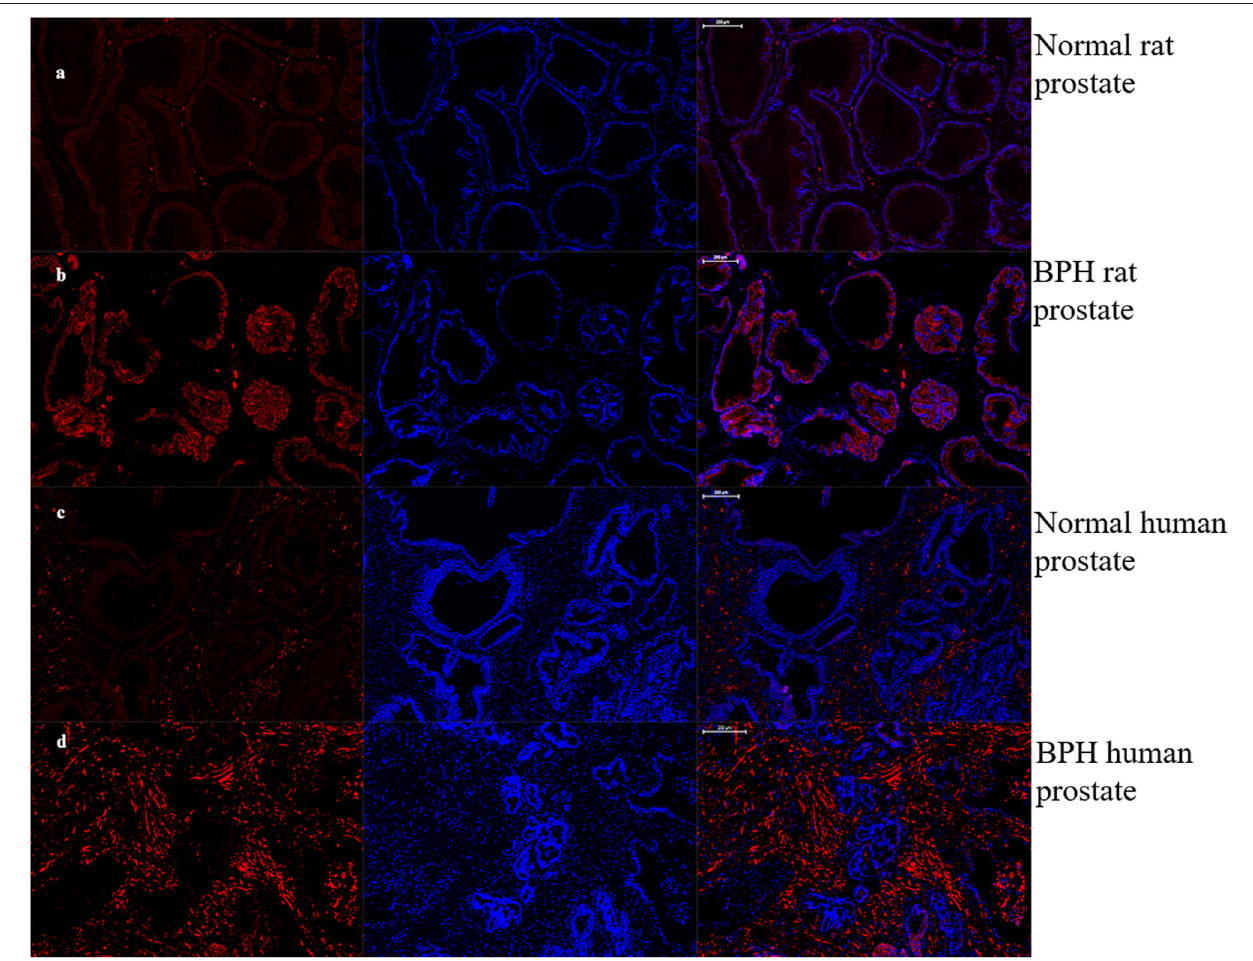
FIGURE 8 | Immunofluorescence of OTR. Left: Cy3-immunofluorescence (red) indicates OTR was abundantly observed in prostate. Middle: DAPI (blue) indicates nuclear staining. Right: Merged image (magnification × 50). (a) Normal rat prostate. (b) BPH rat prostate. OTR mainly distributed in epithelium. (c) Normal human prostate. (d) BPH human prostate. OTR mainly distributed in